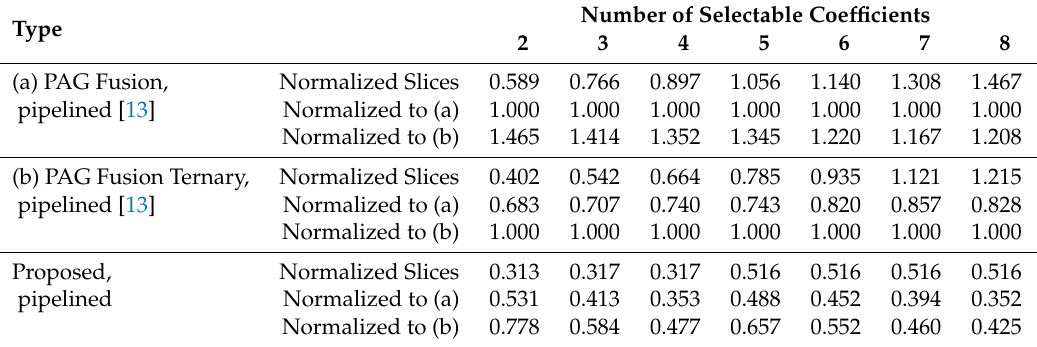
Table 15. Comparison of normalized slice utilization for PAG fusion [13] and proposed (16 × 16)-bit KCMs with two to eight selectable coefficients. Proposed units use 57% fewer slices on average compared to PAG fusion units with two-operand adders and 44% fewer slices on average compared to PAG fusion units with ternary